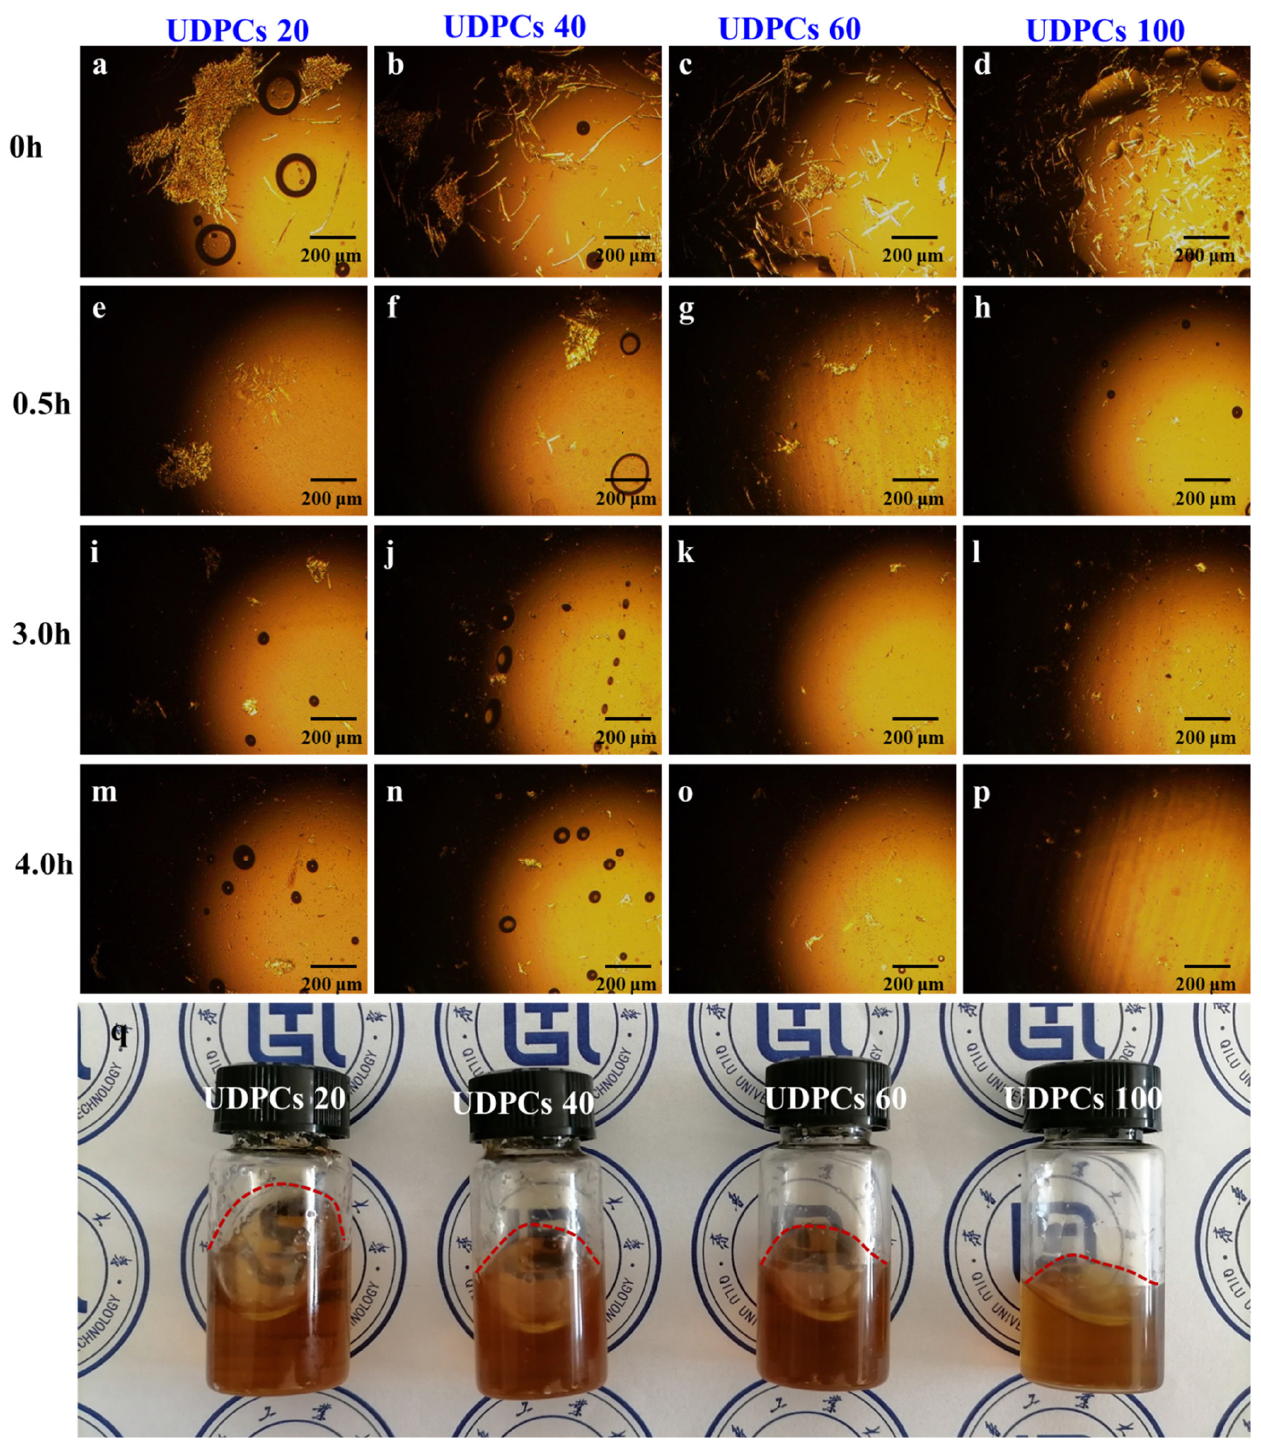
Figure 2. ( a – p ) POM micrographs of UDPCs with different sizes in AmimCl at 80 °C after ( a – d ) 0 hrs, ( e – h ) 0.5 hrs, ( i – l ) 3 hrs, and ( m – p ) 4 hrs. ( q ) Digital picture of cellulose/PE/AmimCl solution mixtures after 4 hrs.